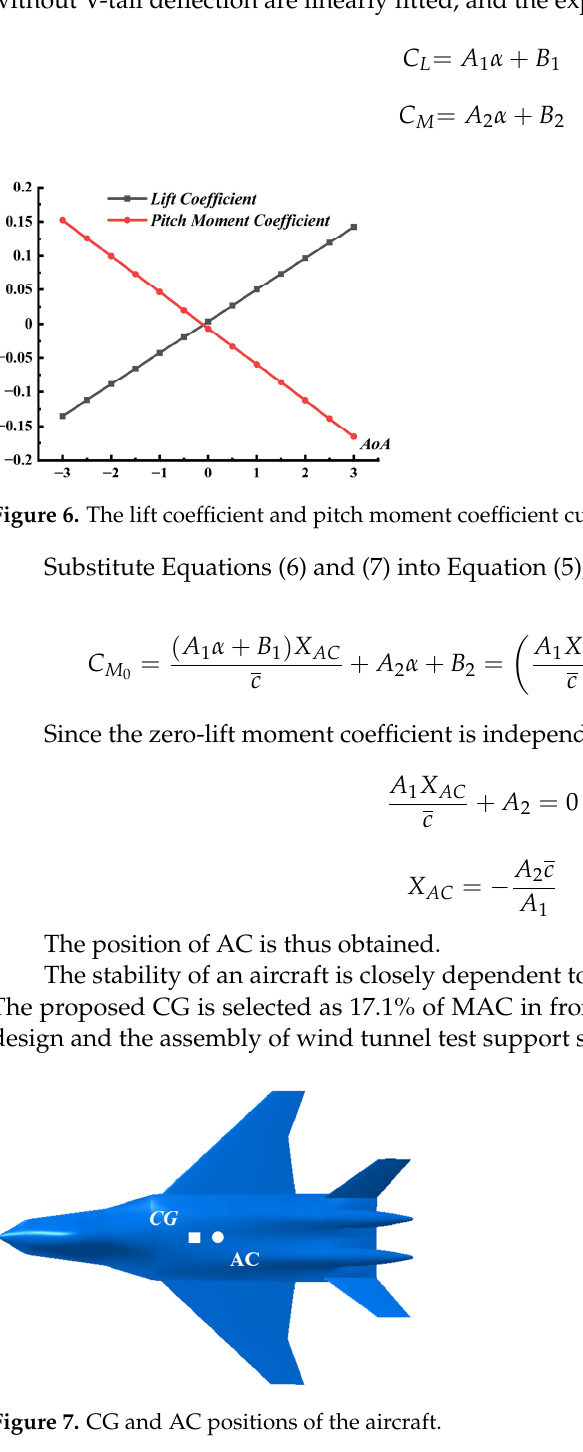
Figure 8. Pitch moment coefficient based on the new CG.